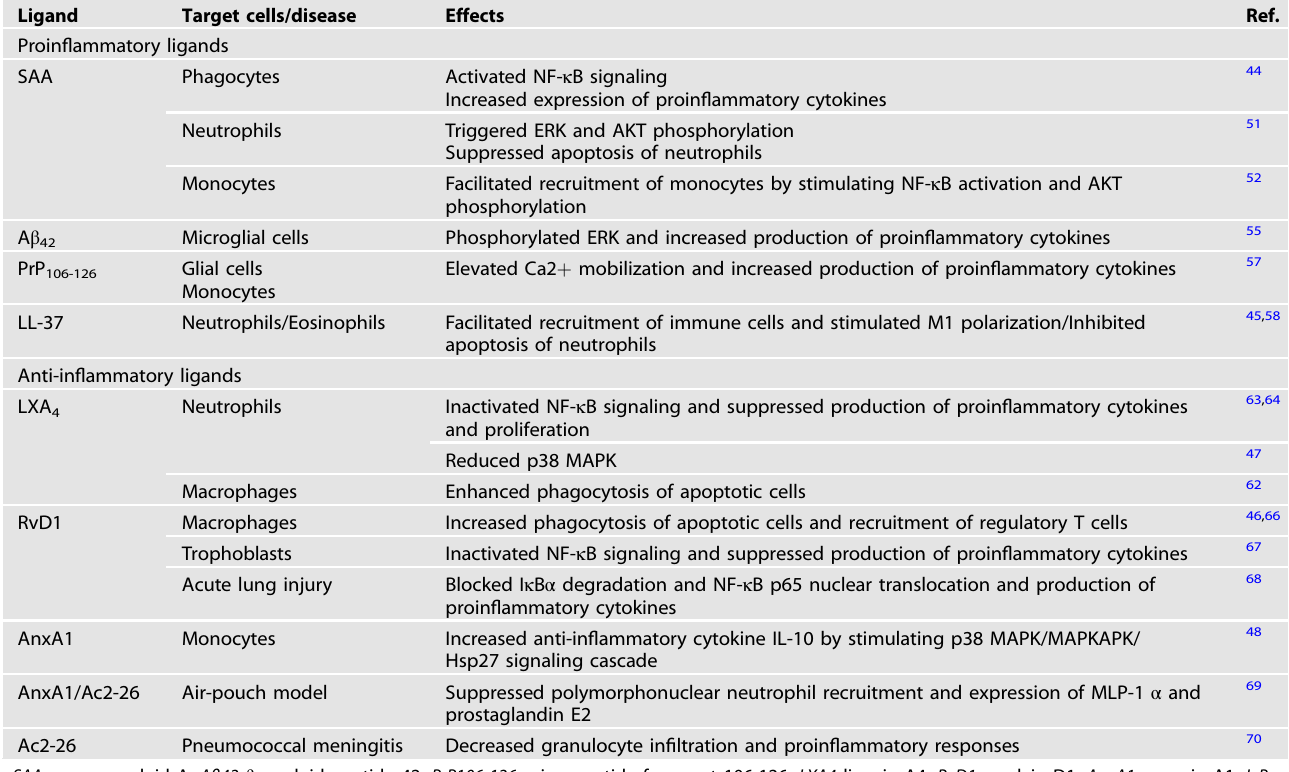
SAA serum amyloid A, A β 42 β -amyloid peptide 42, PrP106-126 prion peptide fragment 106-126, LXA4 lipoxin A4, RvD1 resolvin D1, AnxA1 annexin A1, I κ B α nuclear factor of kappa light polypeptide gene enhancer in B cells inhibitor, alpha, IL-10 interleukin-10, MAPK mitogen-activated protein kinase, MLP-1 α macrophage in fl ammatory protein-1 α